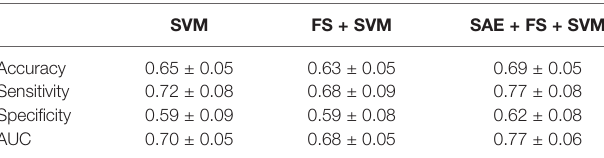
TABLE 4 | Classi fi cation results for healthy controls (HC) and Alzheimer ’ s disease (AD) by support vector machine (SVM), feature selection (FS) + SVM, and sparse autoencoder (SAE) + FS +